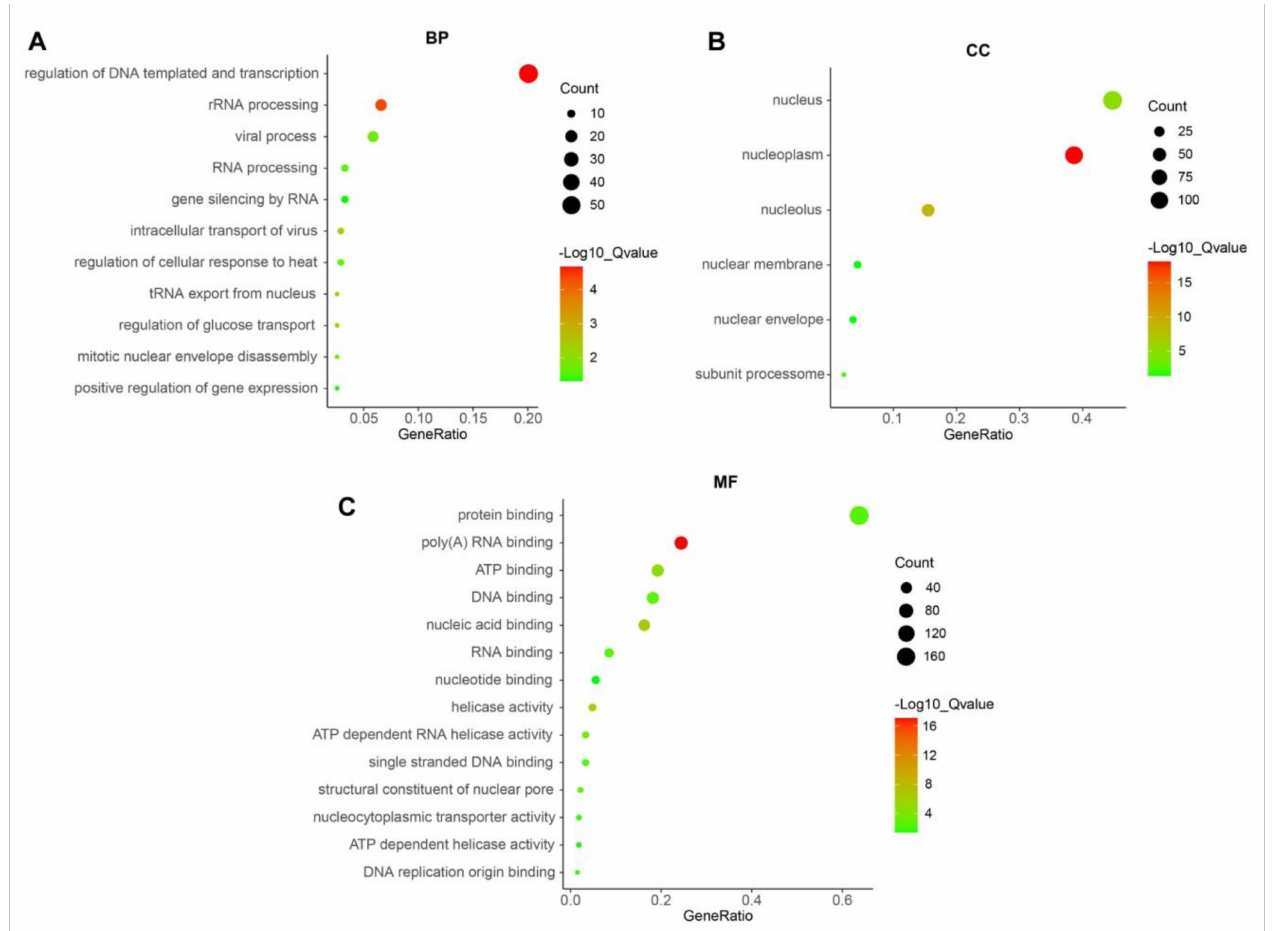
Figure 7. The GO analyses of PUS7 in ovarian cancer. The bubble diagrams were analyzed using PUS7-related genes and exhibited the biological processes ( A ), cellular components, ( B ) and molecular functions ( C ) of